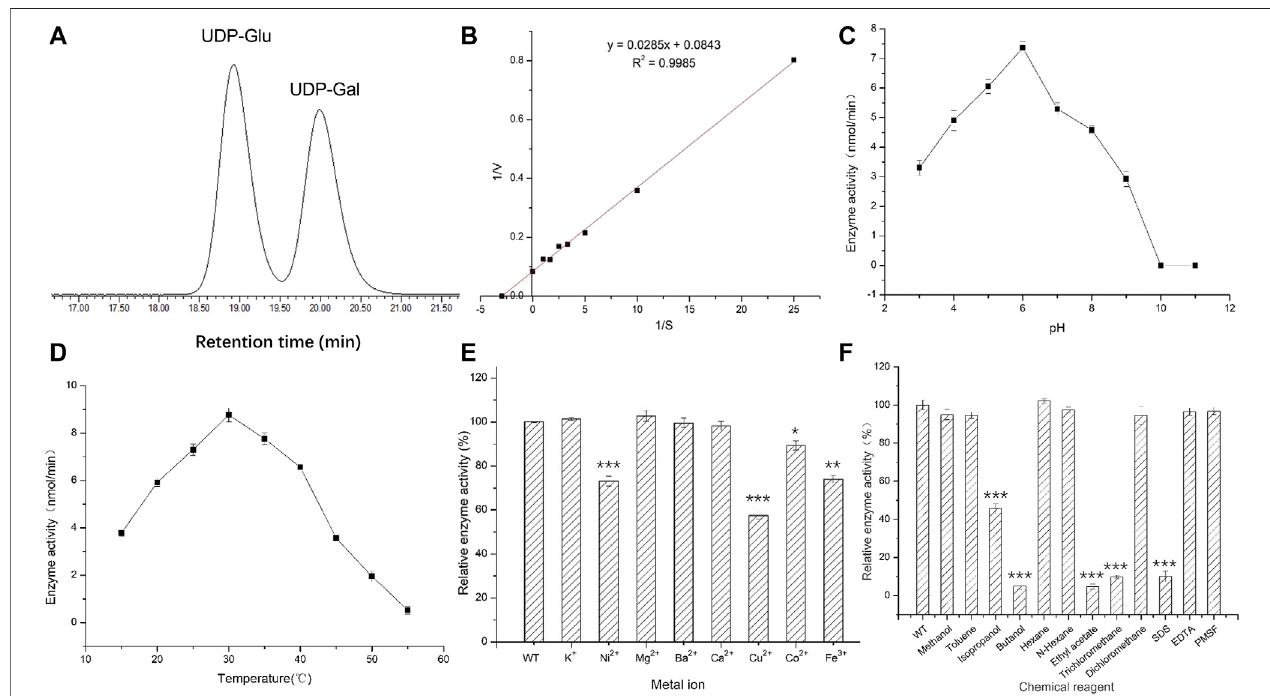
FIGURE 4 | Activities of recombinant protein expressed in E. coli . (A) High performance liquid chromatography detection separation UDP-Glu and UDP-Gal. Peak 1: UDP-Glu; Peak 2: UDP-Gal. (B) Double reciprocal graph. (C) Optimal pH for activity. (D) Optimal temperature for activity. (E) The effect of metal ions on enzyme activity. (F) The effect of chemical reagents on enzyme